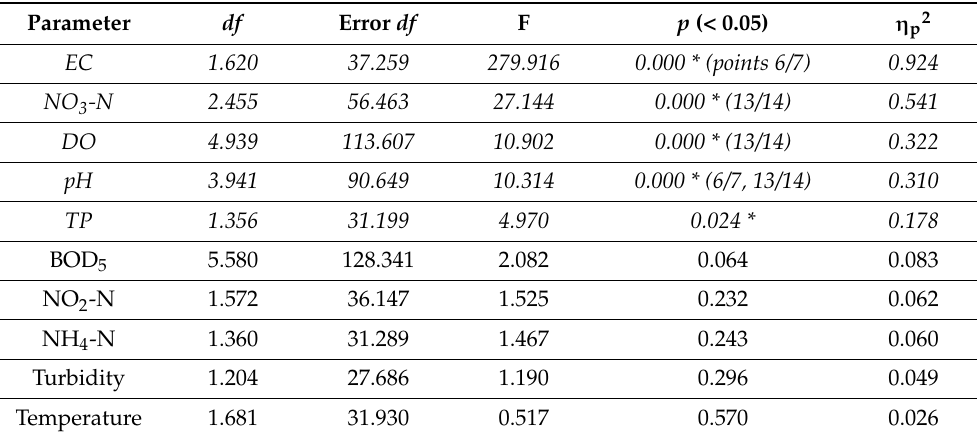
Table 5. Summary of the results of the within-group analysis of variance for repeated parameters (ANOVA)—a variant for all research points (this